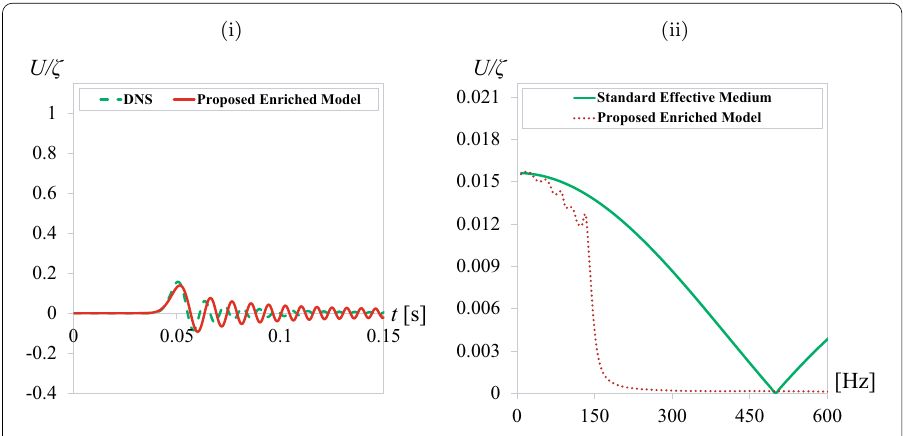
Fig. 7 Metamaterial 1— i Homogenized displacement profile at x = 20 D for loading frequency F at 1000 Hz, with respect to relaxation time [A] ( κ = ∞ ), and ii the respective frequency plot arising from Discrete Fourier